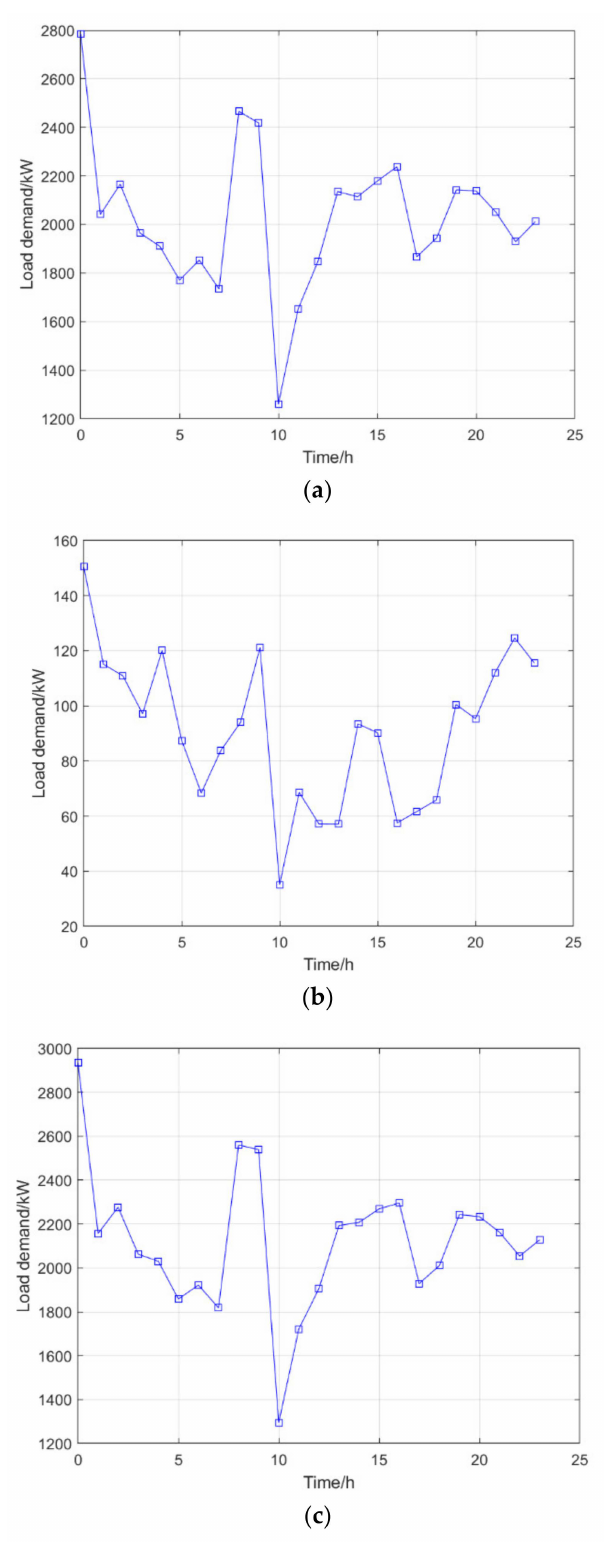
Figure 20. Fast charging demand load at 150 electric taxis. ( a ) Charging demand generated by electric taxis in charging stations. ( b ) Charging demand for electric taxis at their current location. ( c ) Charging needs generated by electric